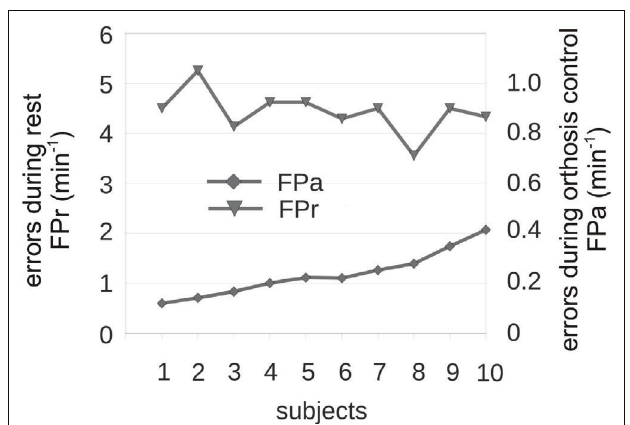
FIGURE 2 | Performance measures of hand orthosis control in 10 subjects. This fi gure displays the errors during orthosis control (FPa; right y -axis: